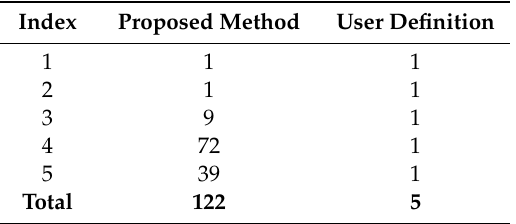
Table 2. Number of screen changes in 360-degree video.